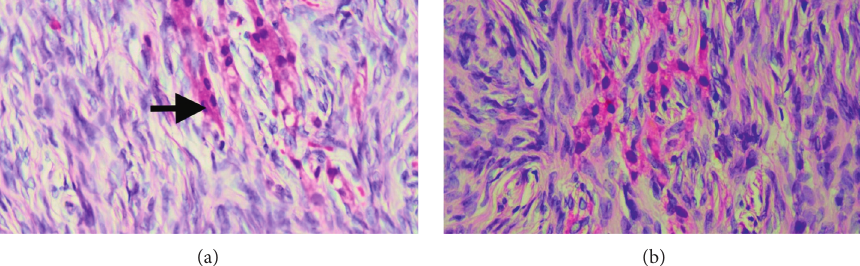
Figure 2: Rod-like structure resembling a Reinke crystal (a, arrow, H&E, 400x). Leydig cells with cytoplasmic vacuolation and brown lipofuschin pigment (b, H&E,